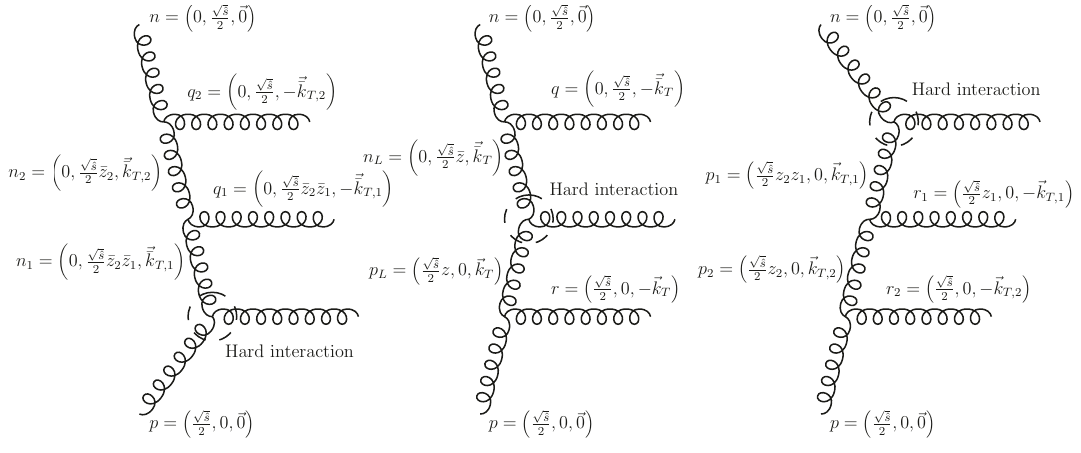
Figure 6 . Feynman diagrams giving the LL x contributions to the double emission process in the small- x limit. Crossed diagrams are omitted. The relevant kinematics is displayed in terms of light-cone Sudakov components in the high energy